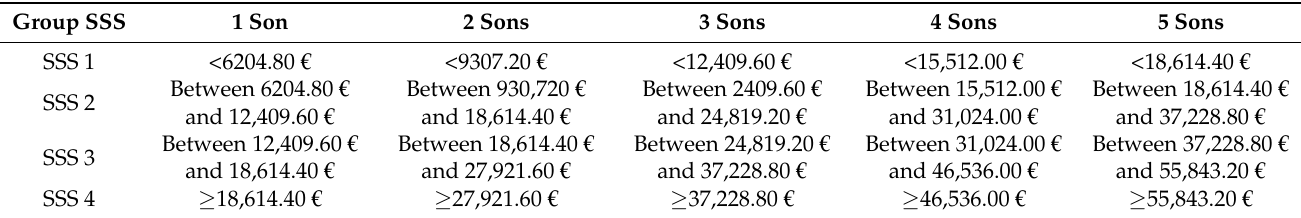
Table 1. Annual income by school social support